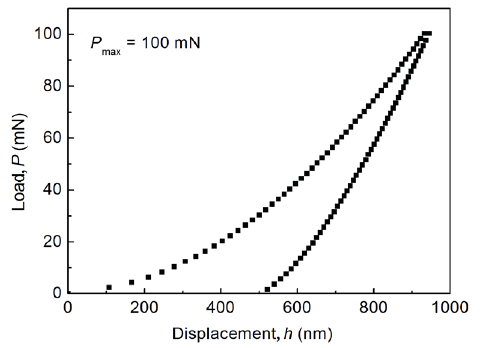
Fig. 2 Typical load − displacement curve measured for fused silica ( P max = 100